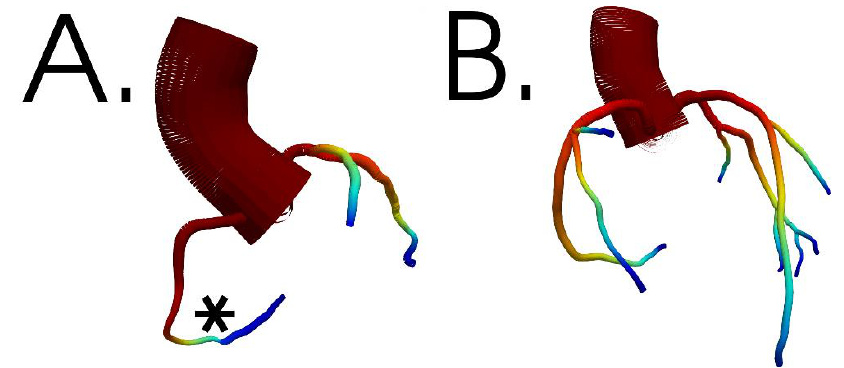
Figure 8. Pressure (arbitrary units) distribution in two representative solid models (geometries) gen- erated using our recent imaging data (unpublished). ( A ) Geometry 1 with the ‘*’ in panel ( A ) indicates the stenosis location. ( B ): Geometry 2 where the location of the stenosis is being investigated.